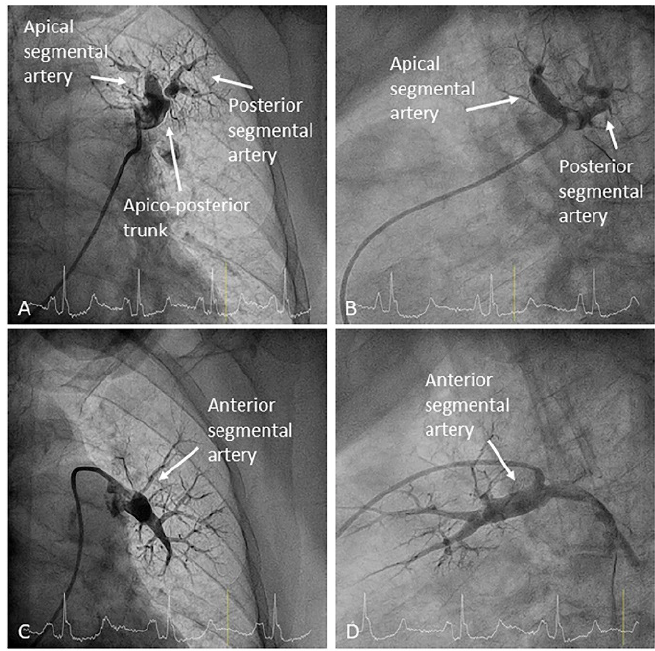
Figure 3. Left upper lobe arteries: ( A , B ) apico-posterior trunk (A1/2) and ( C , D ) anterior segmental branch (A3). ( A , C ) Anteroposterior view and ( B , D ) lateral view.